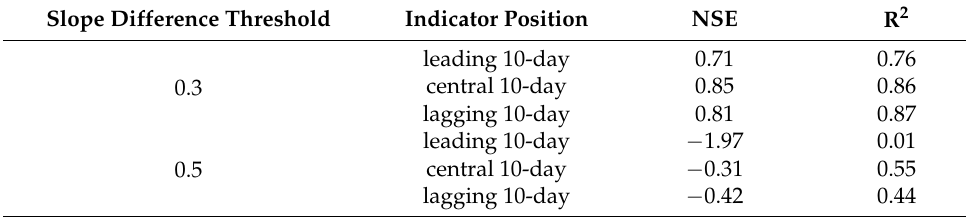
Table 2. Accumulation phase inflection point model parameter